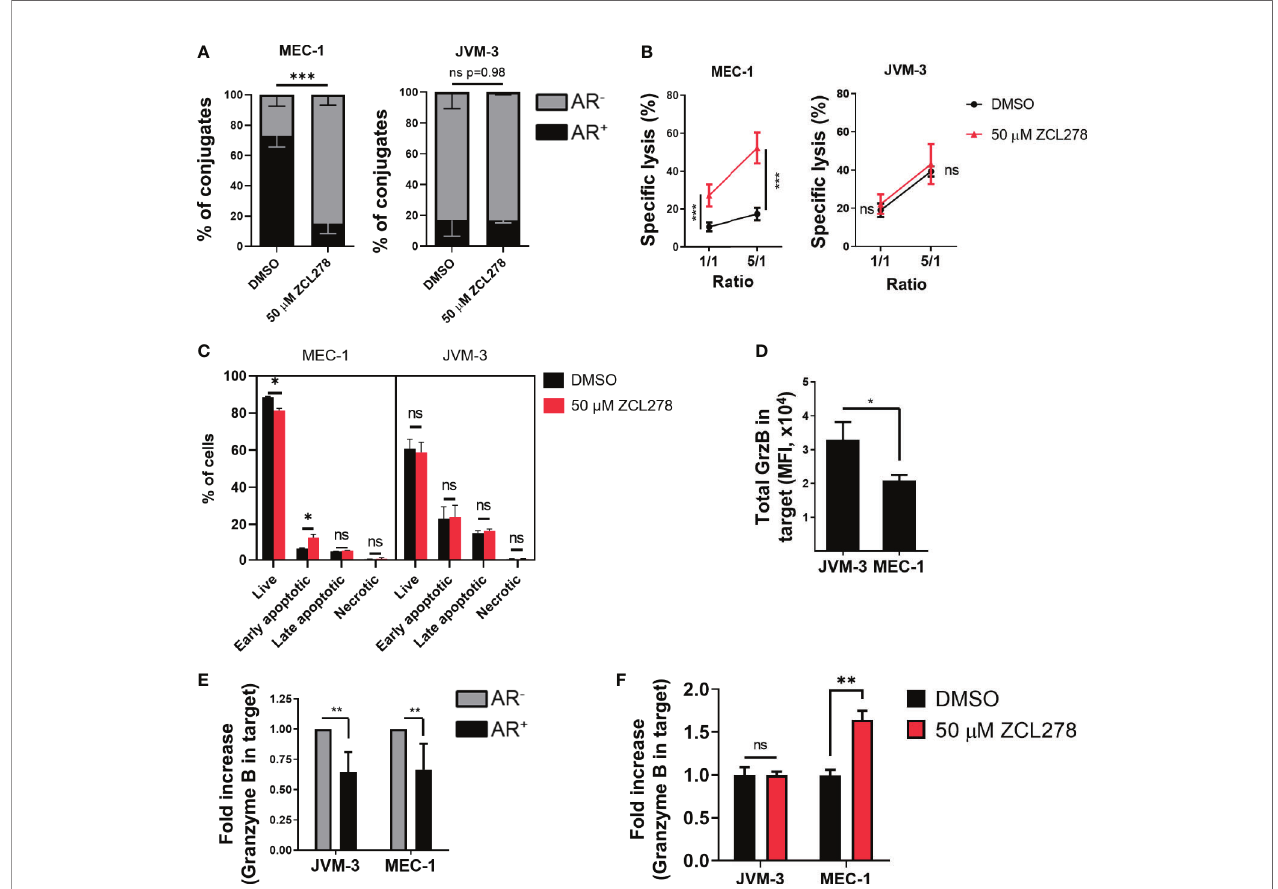
FIGURE 3 | Pharmacological inhibition of Cdc42 increases CLL cell susceptibility to NK cell attack by lowering actin response frequency. (A) Quantitative Imagestream analysis of CLL-NK cell conjugates. CLL cells were pre-treated with 50 µM ZCL278 and analyzed for their actin response frequency in conjugates with NK-92MI cells. *** denotes p < 0.0001 (B) NK cell-mediated cytotoxicity against DMSO- or ZCL278-treated CLL cells. Pre-treated JVM-3 and MEC-1 cells were co- cultured for 4 hrs with NK-92MI cells at E:T ratios of 1:1 and 5:1. Cell death was evaluated by To-Pro-3 staining and adjusted to NK cell-speci fi c lysis. *** denotes p < 0.0001 (C) Flow cytometry analysis of DMSO- or ZCL278-pretreated CLL target cells after 45 minutes of co-culture with effector NK-92MI cells at a 1:1 E:T ratio. Apoptosis was evaluated by Annexin V and PI staining. * denotes p < 0.05, ** denotes p < 0.001, *** denotes p < 0.0001 (D) Imagestream analysis of total granzyme B load in target cells conjugated to NK-92MI cells after 45 minutes of co-culture. * denotes p < 0.05 (E) Target cells were categorized into AR + (black) and AR - (grey) and granzyme B load in target cells evaluated. Data was normalized to AR - conjugates. ** denotes p < 0.001 (F) Imagestream analysis of intracellular granzyme B in target cells after ZCL278-induced Cdc42 inhibition. ** denotes p < 0.001. ns, non signi fi